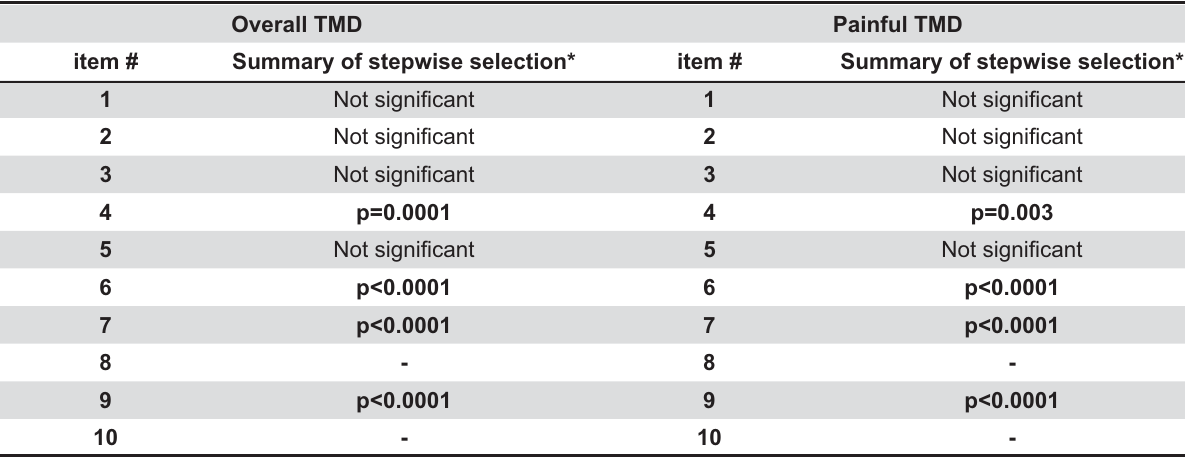
Table 3- Results of the multivariate logistic regression model for selecting items, both for overall temporomandibular disorders (TMD) and painful TMD